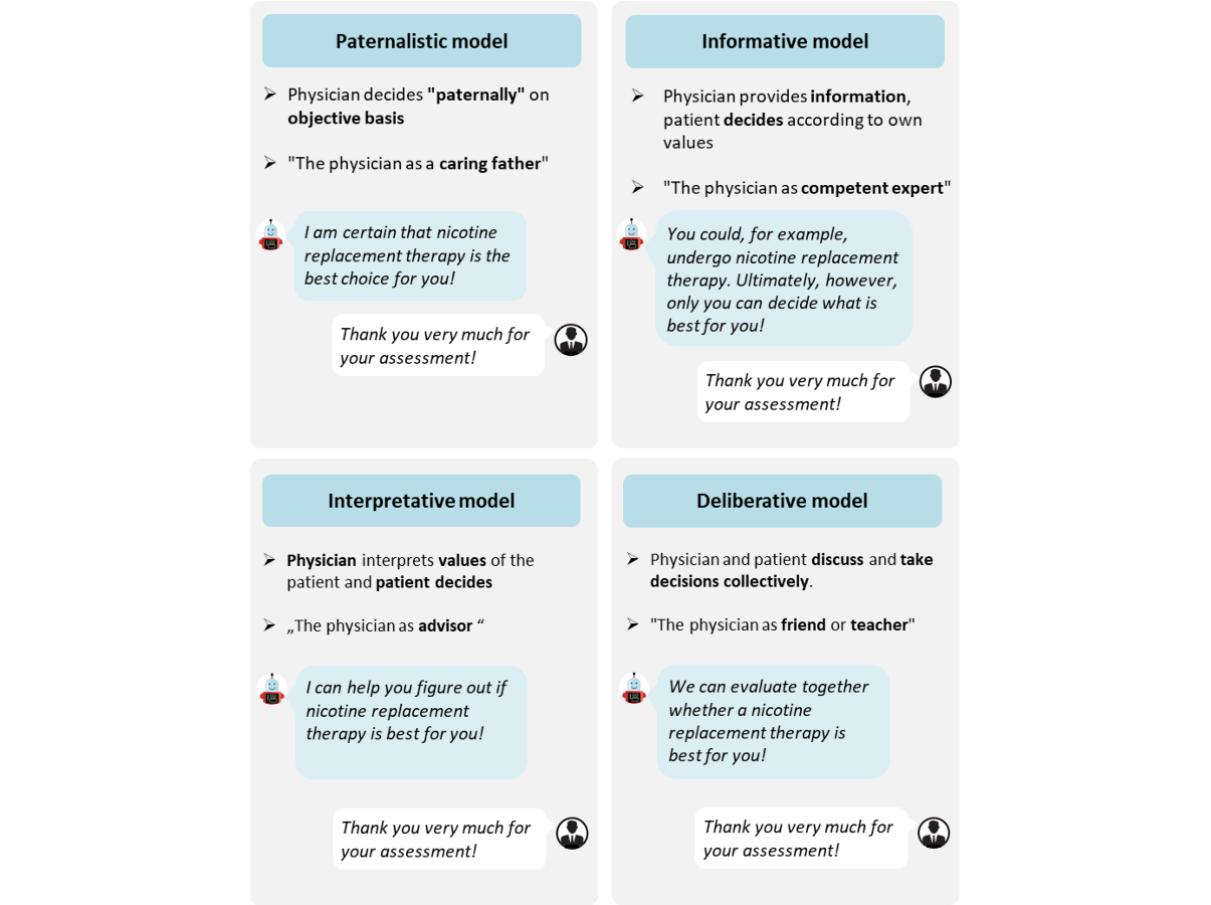
Figure 1. Illustrations outlining the four physician-patient interaction